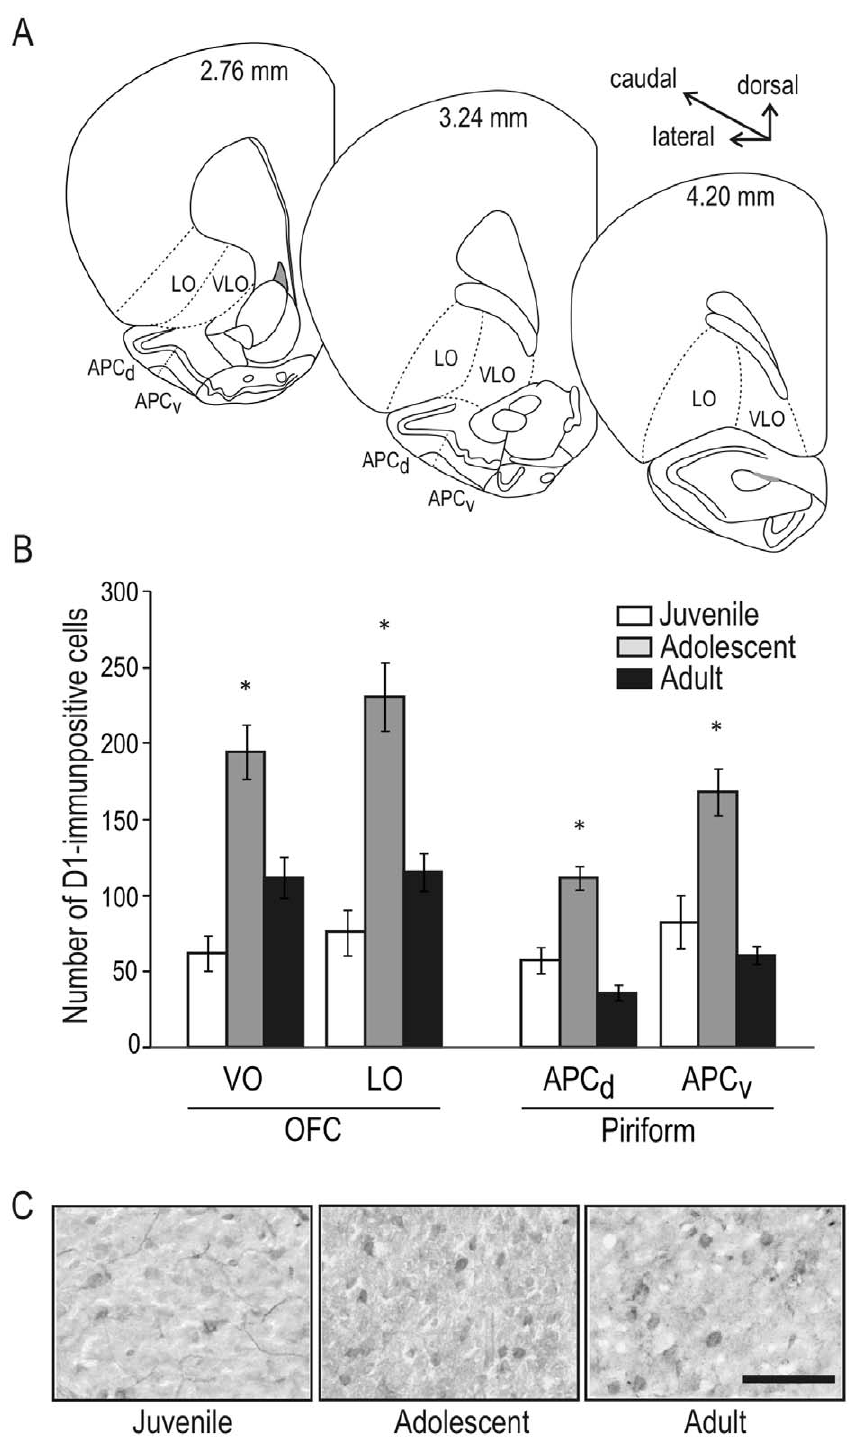
Figure 4. Dopamine D1 receptor protein expression increases in adolescence. A) Subregions of the OFC (LO and VLO) and piriform cortex (APCd and APCv) sampled to determine the number of D1 receptor-immunopositive cells at each age. Drawings of the right hemisphere shown, adapted from Paxinos and Watson (2007). Uniform sampling boxes were placed randomly within each area and all immunopositive cells were counted. All counts were performed by experimenters blind to the age and identity of the sections. B) Average number of D1-immunopositive cells counted in each sampled region for juvenile (white bars), adolescent (gray bars) and adult rats (black bars). Within each subregion, a significant increase in the number of immunolabeled cells was found in adolescence compared with either juveniles or adults (* p , 0.001). C) High-power photomicrographs of sampled regions in the OFC of juvenile, adolescent and adult rats. Scale bar=100 m m, applies to all photomicrographs in C.